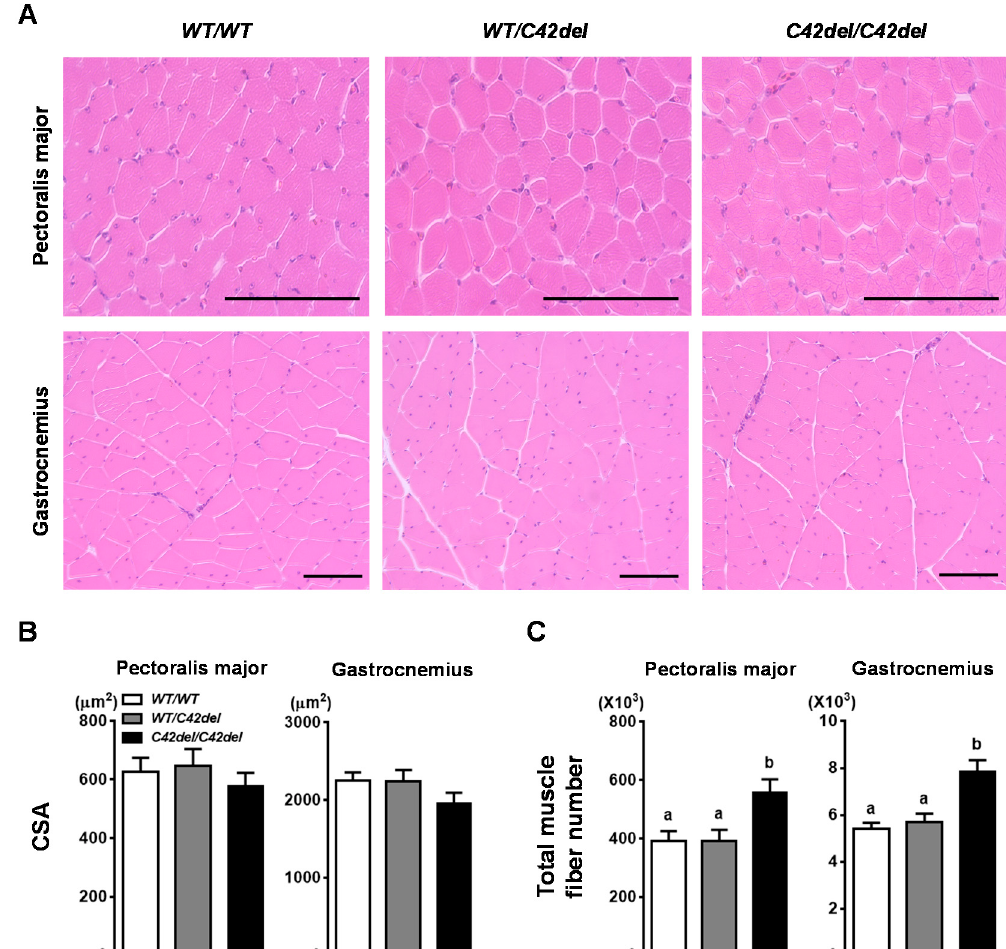
Figure 4. Morphological differences of pectoralis major and gastrocnemius muscles among groups in 6-week old female quail. ( A ) Histological comparison of hematoxylin and eosin stained pectoralis major and gastrocnemius muscles. Scale bar: 100 μ m. ( B ) Comparison of muscle fiber cross-sectional area (CSA). ( C ) Comparison of total muscle fiber number. The values are means ± SEM. n ≥ 5. Statistical analyses were performed by one-way ANOVA followed by Tukey’s multiple comparisons test using the Graphpad PRISM 6.02 program. a–b Means that have no superscript in common in a graph are significantly different ( p < 0.05).